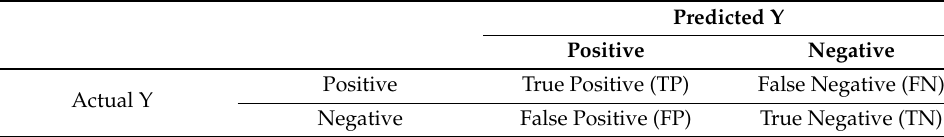
Table 4. Confusion